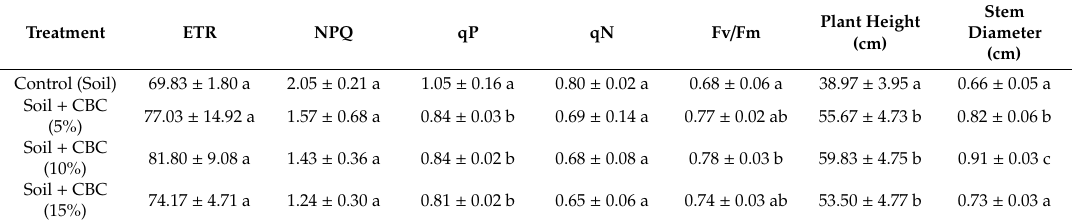
Table 5. Electron transport rate (ETR), non-photochemical quenching coe ffi cient (NPQ), photochemical quenching (qP), non-photochemical quenching (qN), maximum e ffi ciency of PSII photochemistry under dark-adaption (Fv / Fm), plant height, and stem diameter in di ff erent dosages of CBC addition. Treatment ETR NPQ